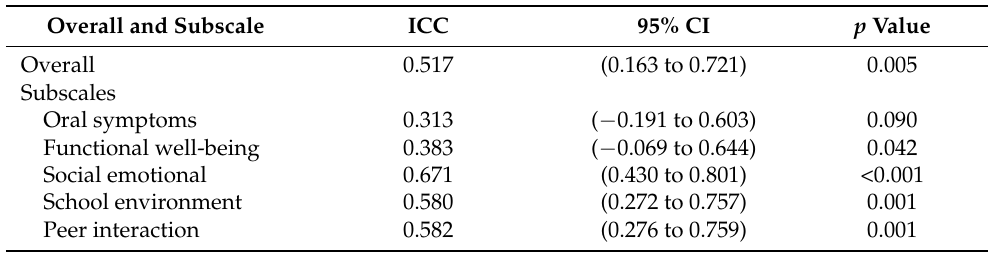
Table 3. Intraclass Correlation Coefficients (ICCs) for COHIP overall and subscale scores between cleft children and